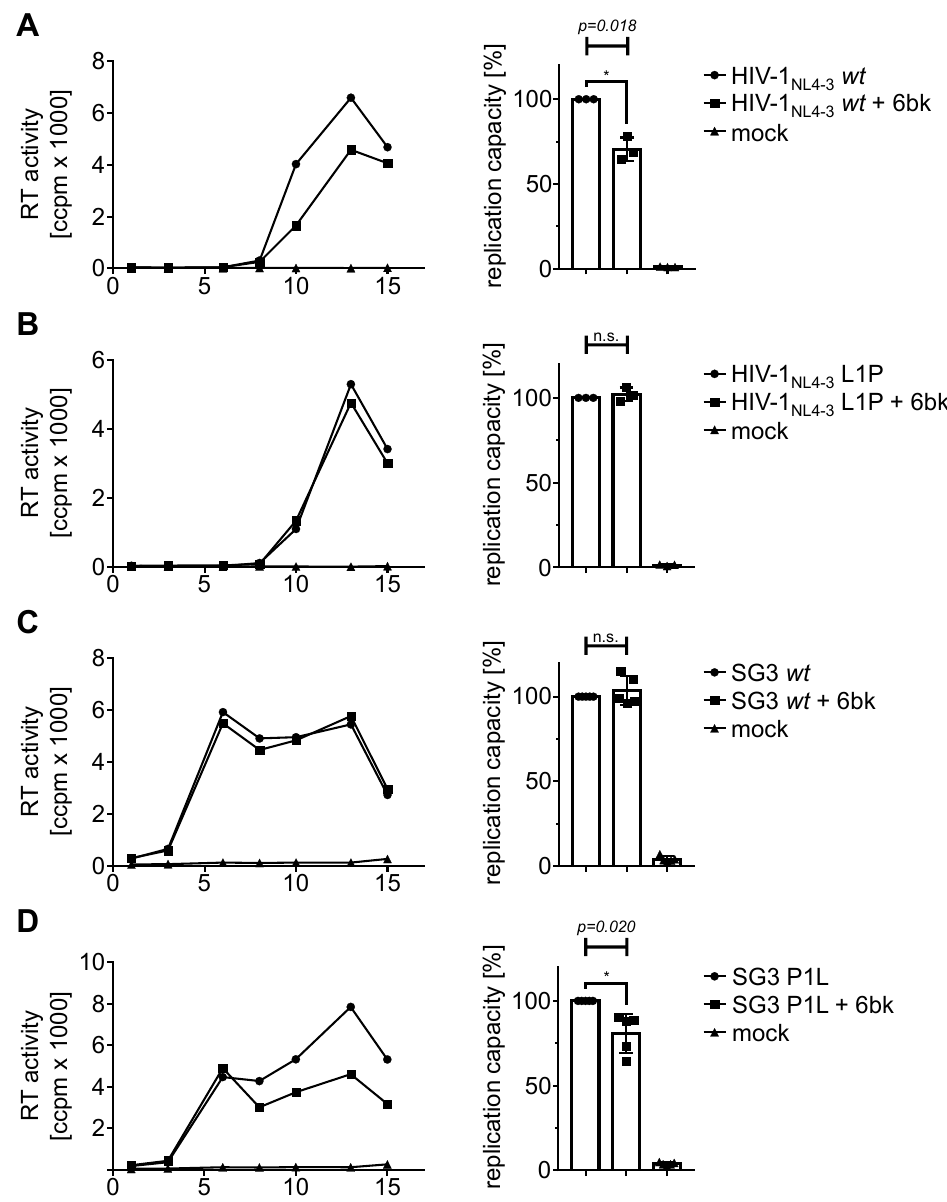
Figure 5. Influence of the IDE inhibitor 6bk on the replication capacities of X4-tropic HIV-1 NL4-3 L1P and SG3 P1L. Representative replication profiles are shown for infected PHA-IL2-stimulated PBMCs. Cells were infected with X4-tropic HIV-1 NL4-3 wt ( A ), HIV-1 NL4-3 L1P ( B ) (each 30 pg p24, MOI 10 − 4 ), SG3 wt ( C ) or SG3 P1L ( D ) (each 60 pg p24, MOI 10 − 2 ) with or without permanent treatment with 10 µ M 6bk (left). Uninfected and untreated PBMCs served as mock control. Replication was assessed by quantification of the virus-associated RT activity contained in cell culture supernatant collected on the indicated dpi. The replication capacity of X4-tropic HIV-1 NL4-3 wt, HIV-1 NL4-3 L1P, SG3 wt or SG3 P1L following infection of PHA-IL2-stimulated PBMCs with and without permanent treatment with 10 µ M 6bk was assessed by calculating the area under the curve (AUC) from each replication profile (right). The replication capacity of untreated cells in each experiment was set to 100%. Scattered blots with columns representing mean values of three (A,B) or five (C,D) independently performed experiments ± SD. One sample t -test was conducted to determine statistically significant differences between the replication capacity of treated and untreated cells (* p < 0.05; n.s. p ≥